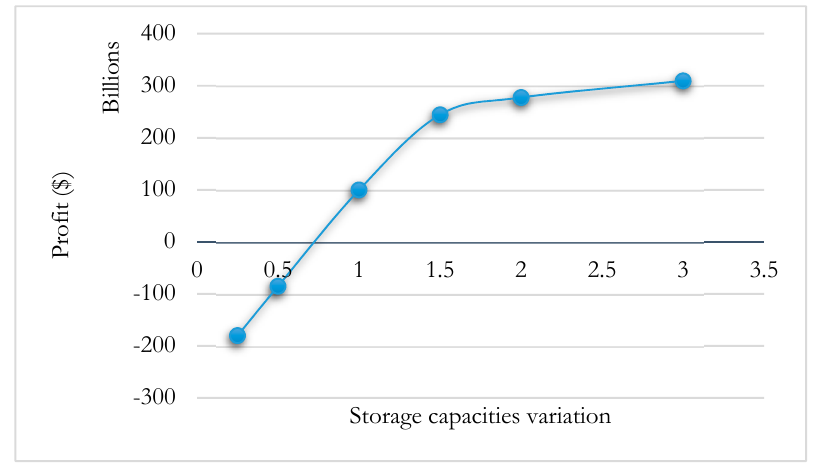
Figure 10. Profitability changes with variation in store capacity.